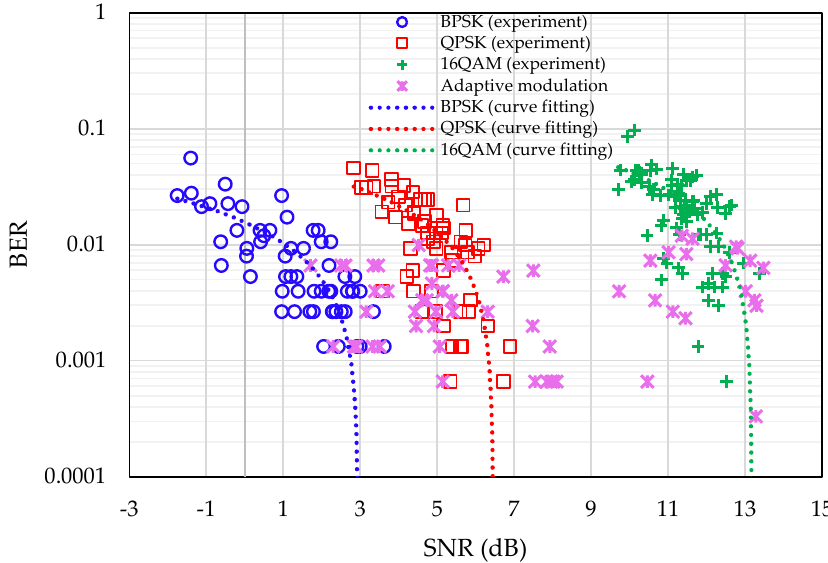
Figure 18. BER performance of the proposed cluster-based adaptive modulation scheme during the